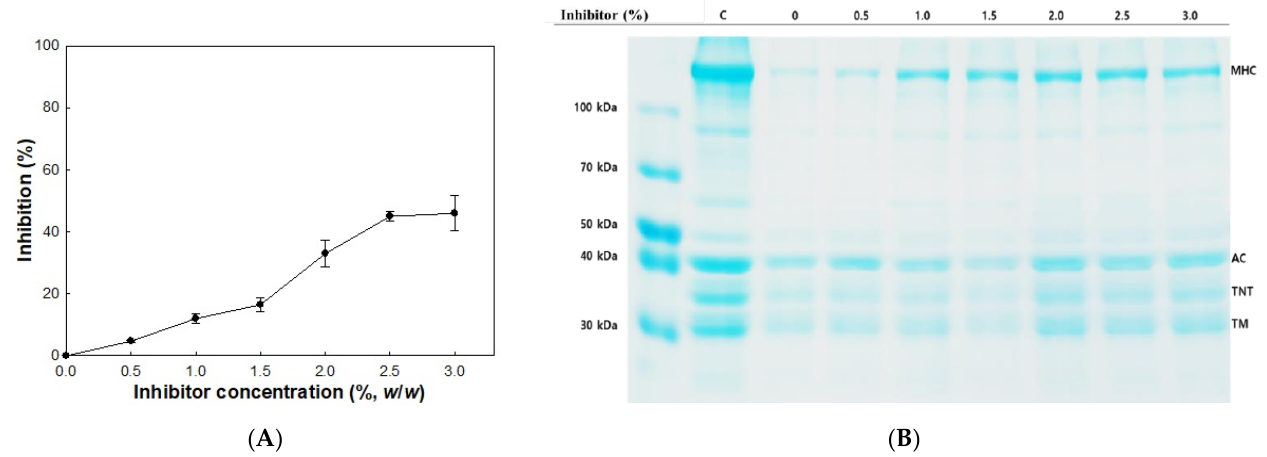
Figure 4. Inhibitory activity ( A ) and autolytic pattern ( B ) of olive flounder surimi with cathepsin L inhibitor. Samples were incubated for 120 min at 60 °C. Myosin heavy chain (MHC); actin (AC); troponin-T (TNT); tropomyosin (TM); control (C).